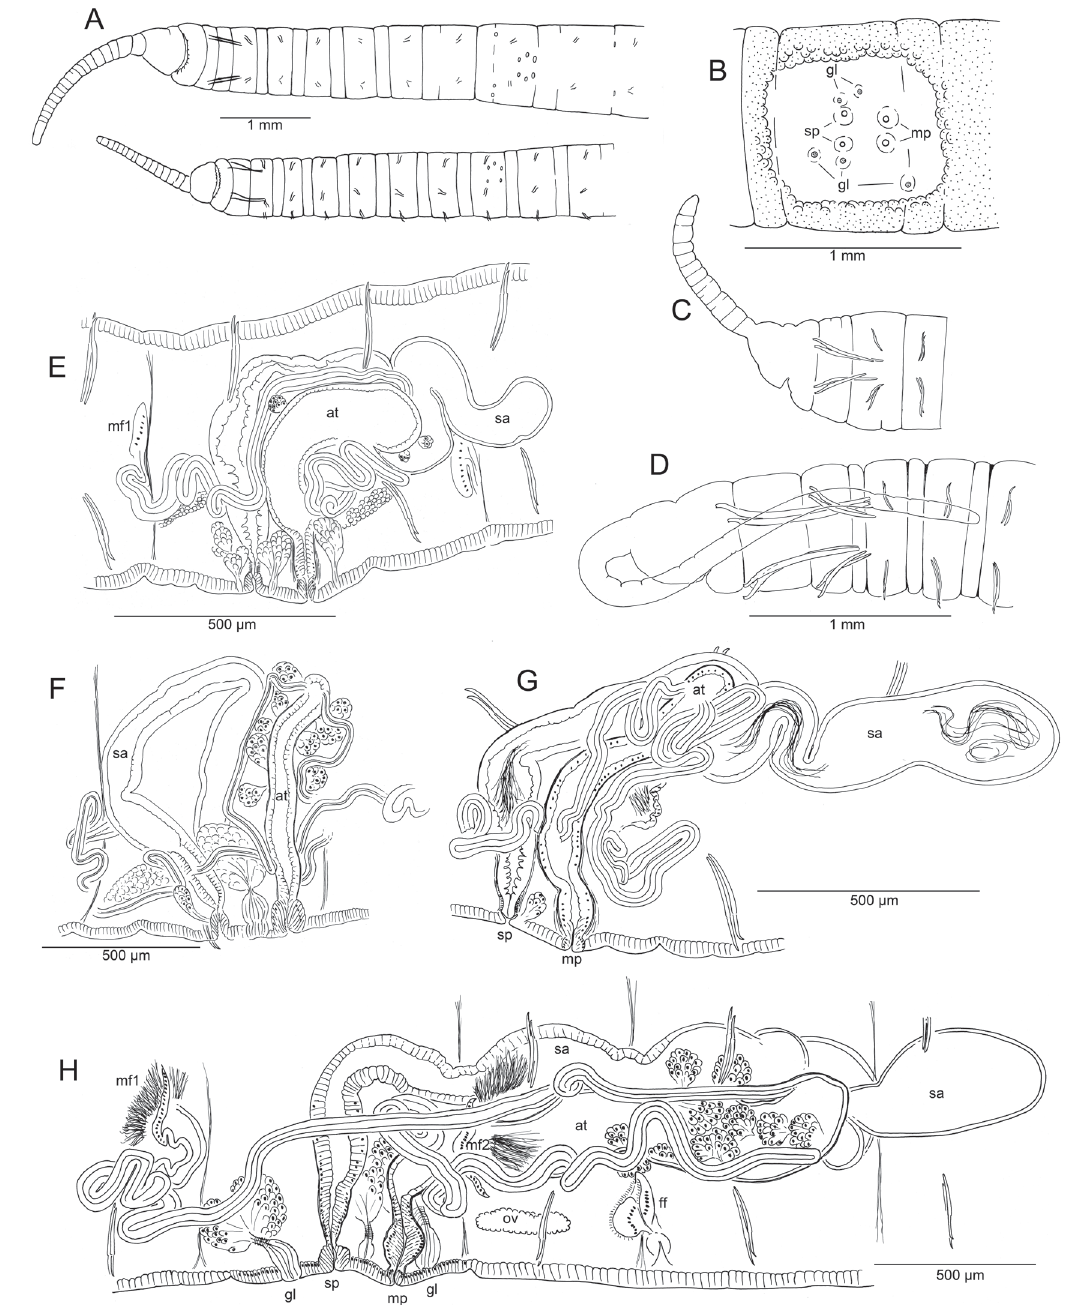
Fig. 11. Guestphalinus elephantinus Fend & Rodriguez sp. nov. A . Ventral view of two worms from Shale Creek, WA (type locality); upper drawing is the holotype, lower is a post-reproductive worm. B . Ventral view of segment IX, showing genital field of a mature worm from Guadalupe Creek, CA; secretory openings of 5 glands are visible, in addition to paired male and spermathecal pores. C . Anterior end, from Peavine Ridge spring, OR, showing position of chaetae in II-IV. D . Anterior end of worm from Middle Fork Satsop River, WA. E . Reproductive organs of a mated worm from Shale Creek (holotype). F . Segment IX of an unmated worm, Peavine Ridge. G . Atrium and spermatheca in IX of a mated, but slightly post-mature worm from Clearwater River, WA; sperm present in spermatheca, but atrium is reduced in size. H . Reproductive organs in segments VIII–XII of a mated, mature worm from Guadalupe Creek,